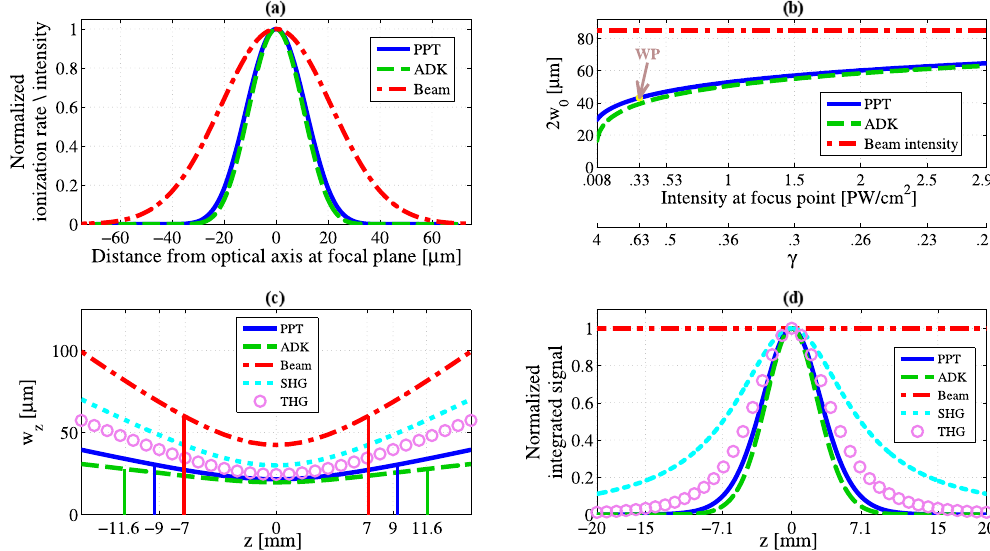
Figure 2. Strong field ionization (PPT & ADK models) driven by a focused Gaussian beam: ( a ) PPT (solid blue) and ADK (dashed green) ionization rate profiles generated by a focused Gaussian beam with the intensity profile shown as red dash-dotted curve; ( b ) The waist diameter as a function of the laser intensity at the focus point (Our experimental working point is indicated by WP); ( c ) Ionization rate width w z (defined at the 1/ e 2 of maximum ionization) of PPT and ADK signals along the optic axis, shown together with SHG,THG and the laser beam width. Solid vertical lines show the distance from the focal plane where w z increases by factor 2 in analogy with the Rayleigh range ( z R ); ( d ) Signal integral across the plane perpendicular to the optical axis under the assumption of constant gas density. Note the variation of the integrated ion signal vs. constant integral of the laser intensity (i.e. power) along the propagation direction.